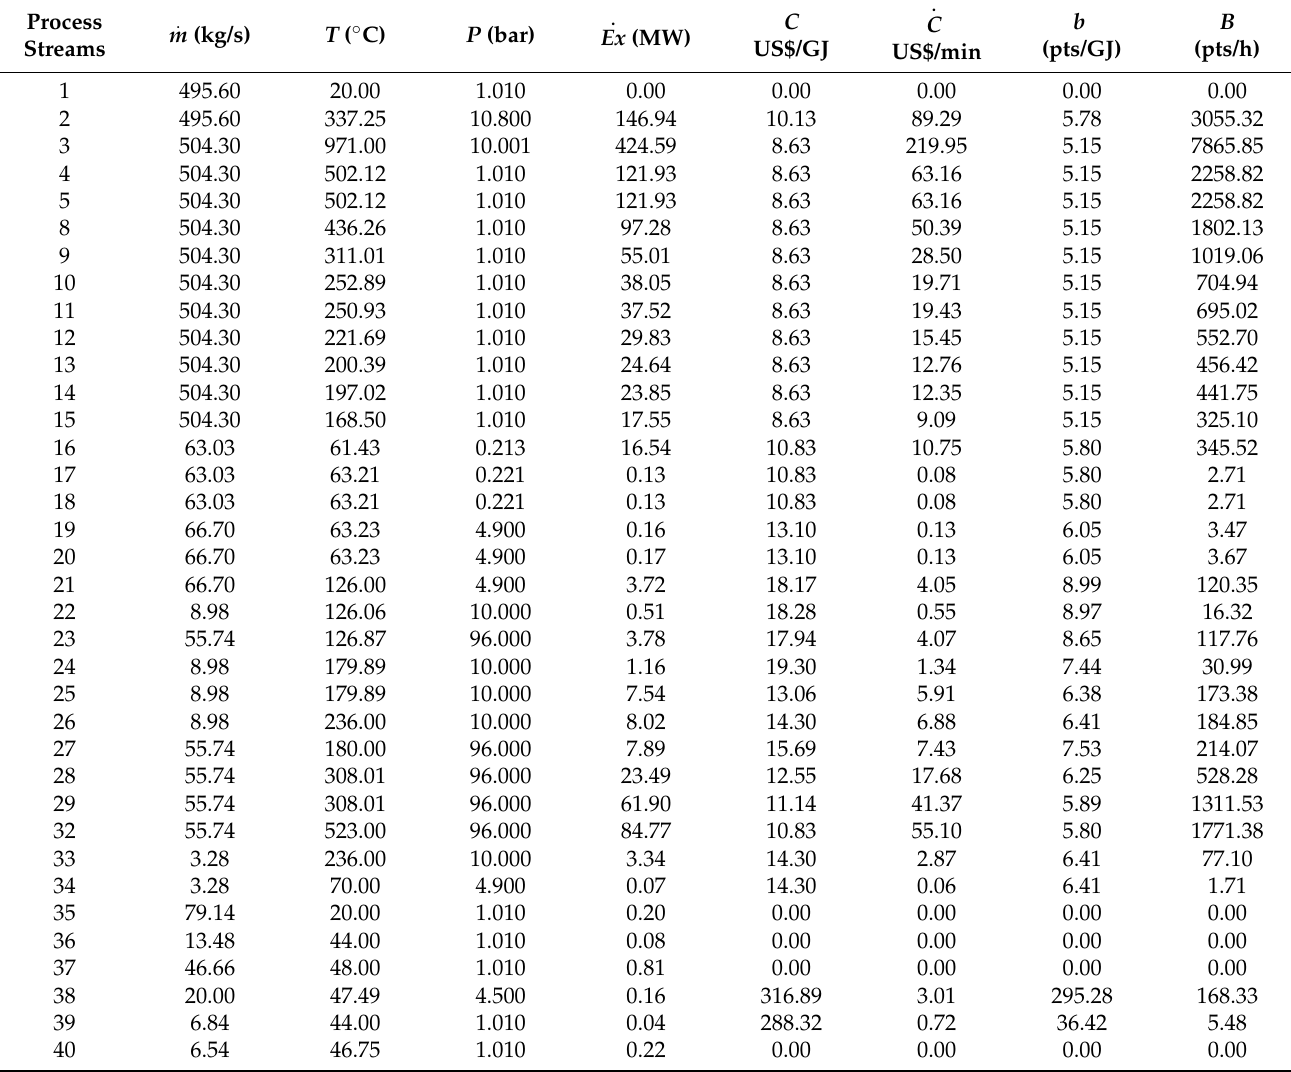
Table A6. Conventional exergy, economic and environmental results for the different process streams. Process